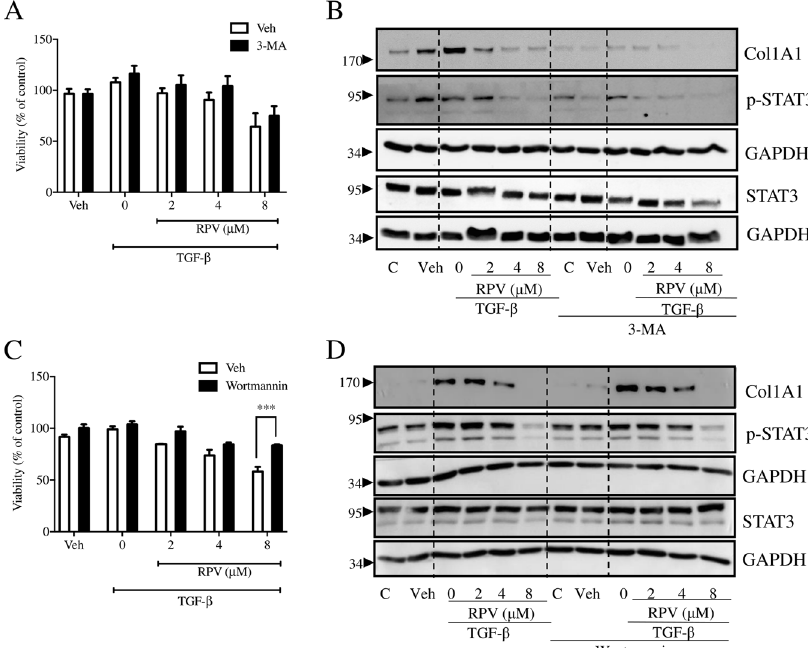
Fig. 6 Co-treatment of RPV with the autophagic inhibitors 3-MA and wortmannin shows a differential effect between the two. Unlike wortmannin which lacked an effect, 3-MA diminished the content of collagen 1A1 produced by activated LX-2 cells. 3-MA did not affect RPV- induced decrease in cell viability while wortmannin rescued it. Viability of LX-2 cells treated with vehicle, TGF- β or TGF- β plus different concentrations of RPV in the presence or absence of 3-MA ( A ) or wortmannin ( C ) was determined with acid phosphatase assay. Bars represent mean ± SEM ( n = 5 for 3-MA and n = 3 for wortmannin); data are expressed as in relation to that of untreated control cells in each experiment for both with and without 3-MA or wortmannin, which was considered 100%. Statistical analysis was by two-way ANOVA with Bonferroni post- test of 3-MA or wortmannin treatment vs vehicle (*** represents a p value < 0.001). B , D Representative WB images of Col1A1, p-STAT3, STAT3, and GAPDH in LX-2 cells exposed to vehicle, TGF- β or TGF- β plus RPV (2, 4, and 8 μ M) for 48 h in the presence or not of 3-MA ( n = 3) or wortmannin ( n =